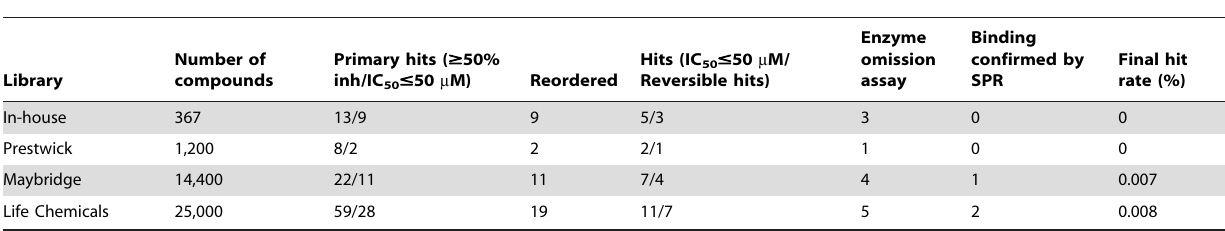
Table 1. Statistical parameters of all screened compounds from four libraries.